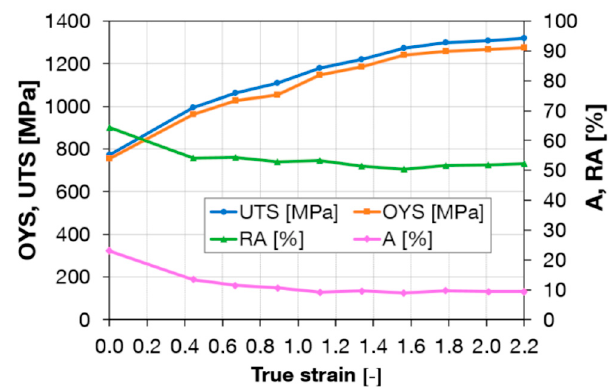
Figure 11. Tensile properties after three passes through the Conform SPD machine and after rotary swaging in relation to true strain.